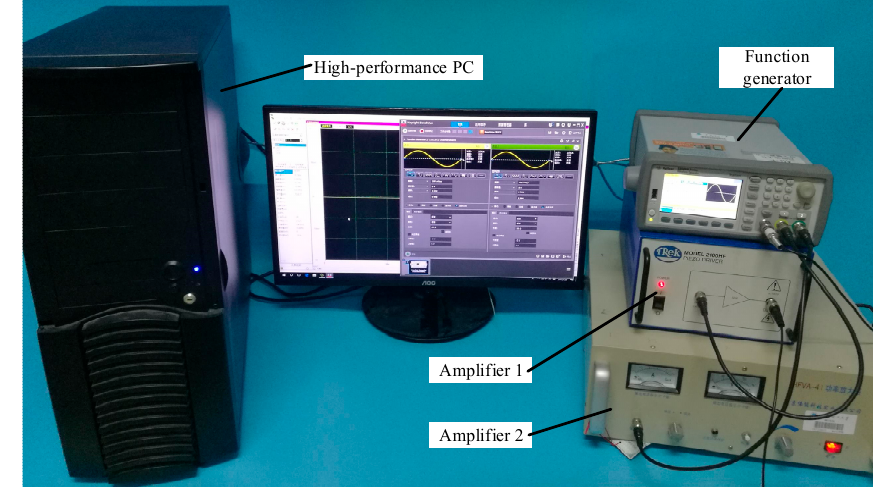
Figure 3. Experimental setup.